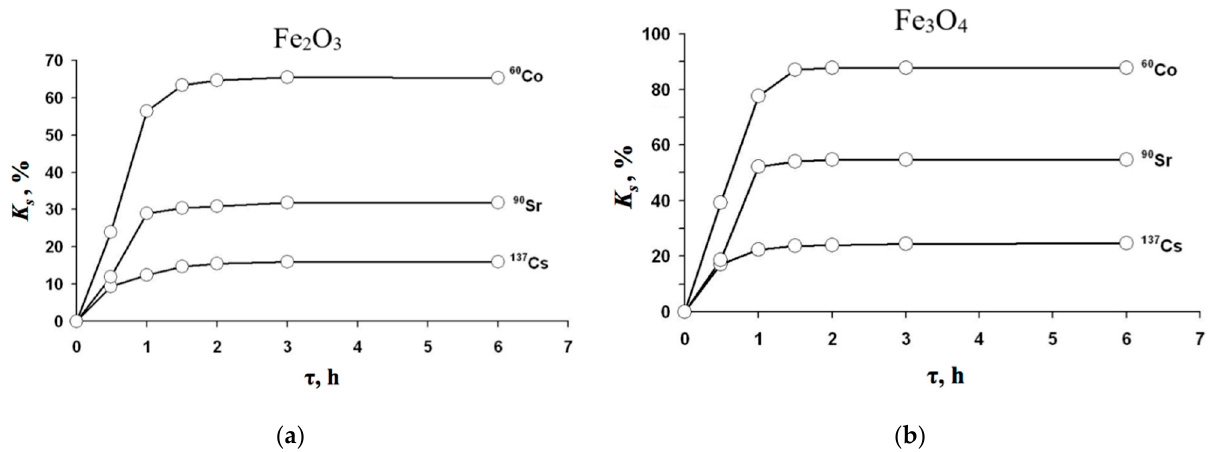
Figure 4. Kinetic sorption diagrams of radionuclides 60 Co, 90 Sr, and 137 Cs at pH 8: ( a ) with particles Fe 2 O 3 ; ( b ) with Fe 3 O 4 .